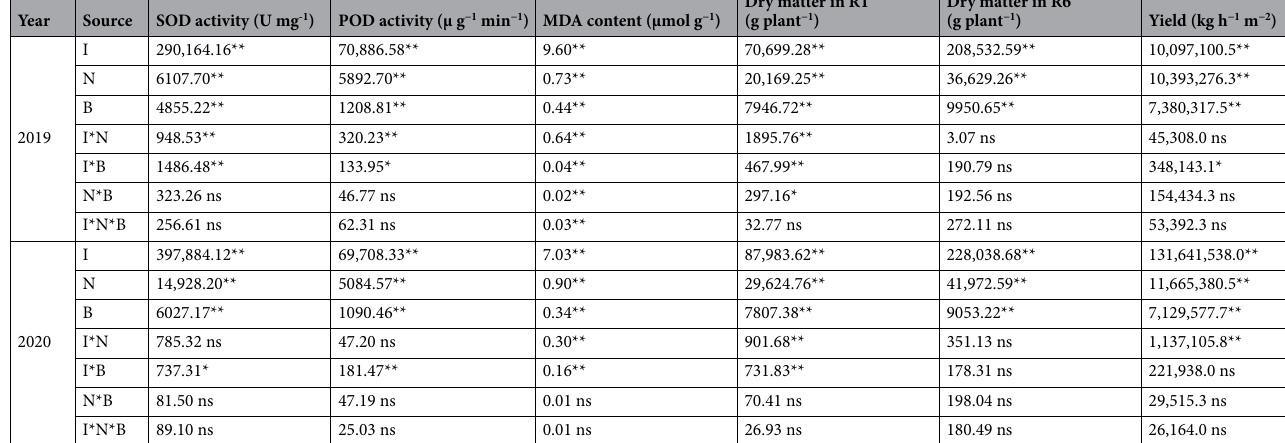
Table 2. Significance of the effects of irrigation methods, nitrogen fertilization levels, bio-char levels and their interactions on maize growth and yield using ANOVA. Numbers were F values. Stars indicated the level of significance (*p < 0.05, **p < 0.01), ns represented insignificant. I represented irrigation methods, including RI and DS; N represented nitrogen fertilization levels, including N0, N150,N300; B represented bio-char levels, including